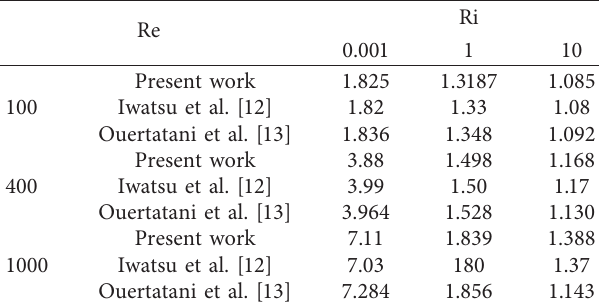
Table 2: Representation of the validation of Nu for different Re and